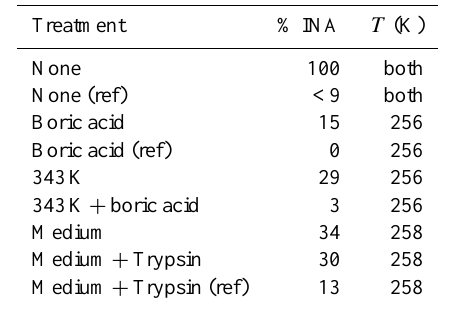
Table 2. An overview of the investigation of birch pollen extracts. The percentage is the relative number of INs in comparison to the untreated aliquot at a given temperature T (K). Lines labeled with “(ref)” refer to reference measurements under the same conditions with pure water instead of